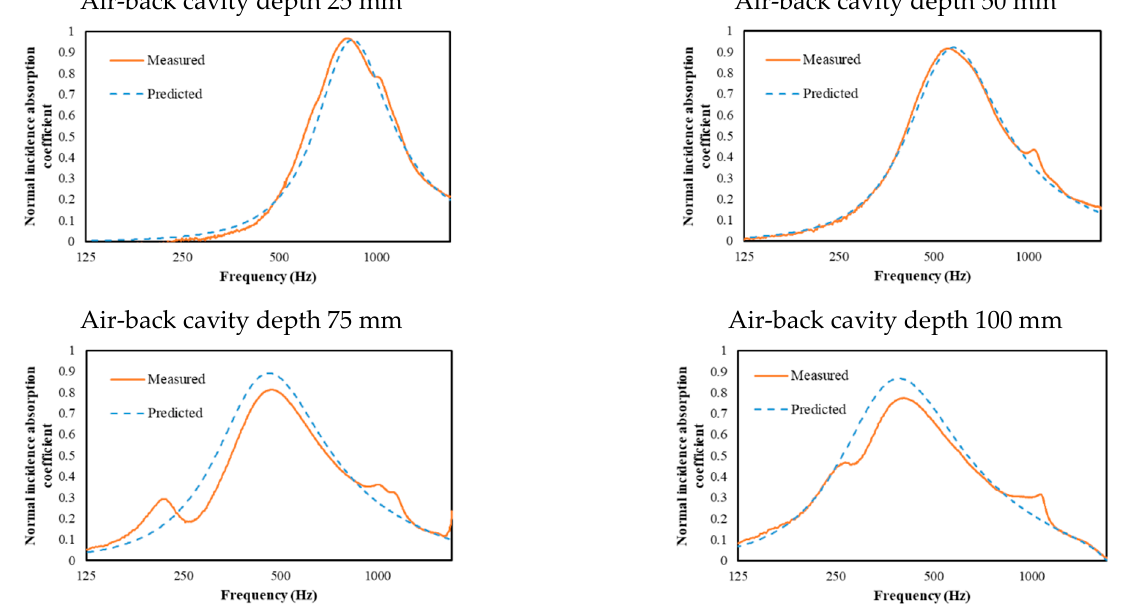
Figure 6. Comparison of the measured and predicted values of the normal incidence sound absorption coefficient of specimen 3. The orange solid line represents the measured values, and the blue dotted line represents the predicted values. Table 3. Mean values of the error indices for the four conditions of air-back cavity depth of specimens 3, 4, 5, 6, and 7.